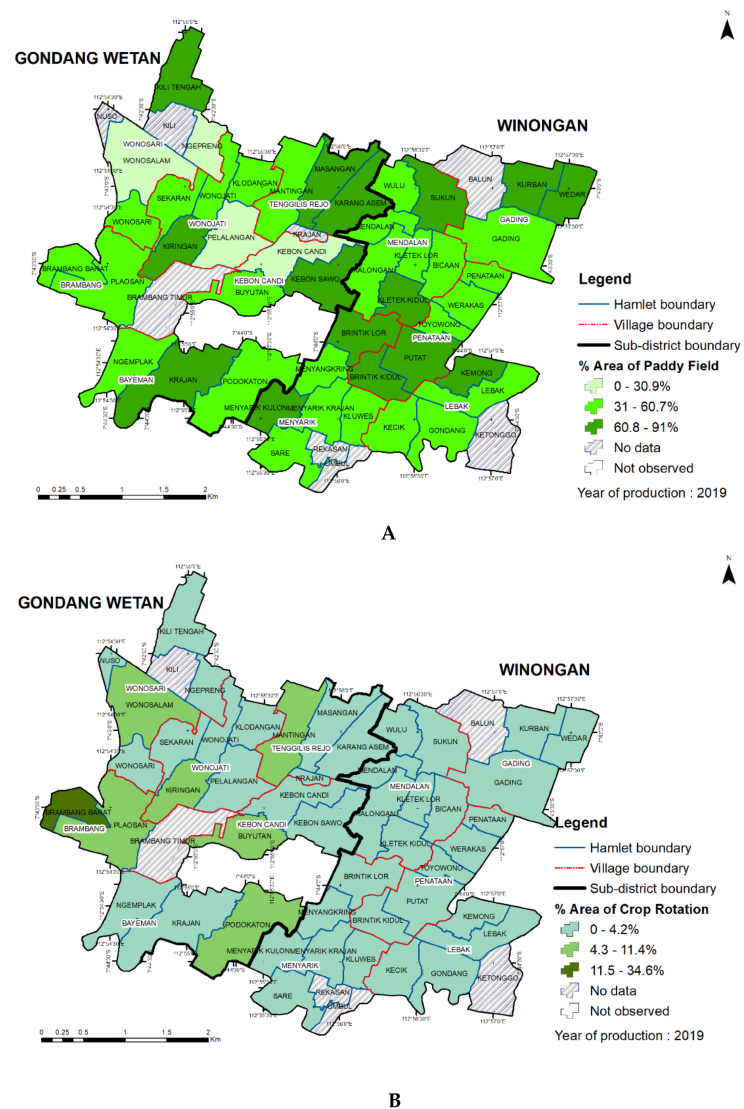
Figure 7. Spatial distribution of the percentage of paddy field area ( A ) and area with crop rotation ( B ) at hamlet